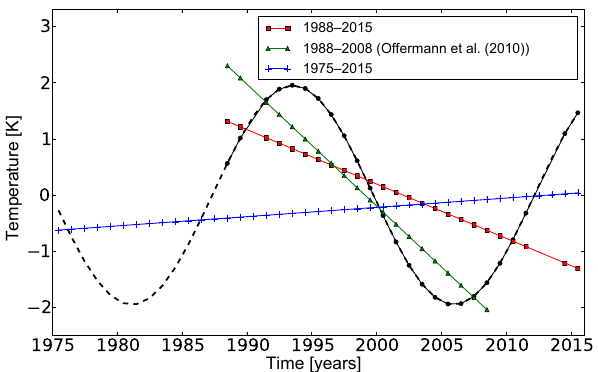
Figure 15. 25-year oscillation of OH ∗ temperatures resulting from the least-square fit using Eq. (10). The coefficients are C sin = (1.95 ± 0.44)K, and P = (24.8 ± 2.1)years. The solid black line with full circles shows the oscillation for the analysed time in- terval 1988–2015 and the dashed black line shows the continuation of this oscillation back to 1975. The red line with squares displays a linear fit to the oscillation for the time interval 1988–2015, the green line with triangles the fit for the interval 1988–2008, and the blue line with plus signs a fit to the interval